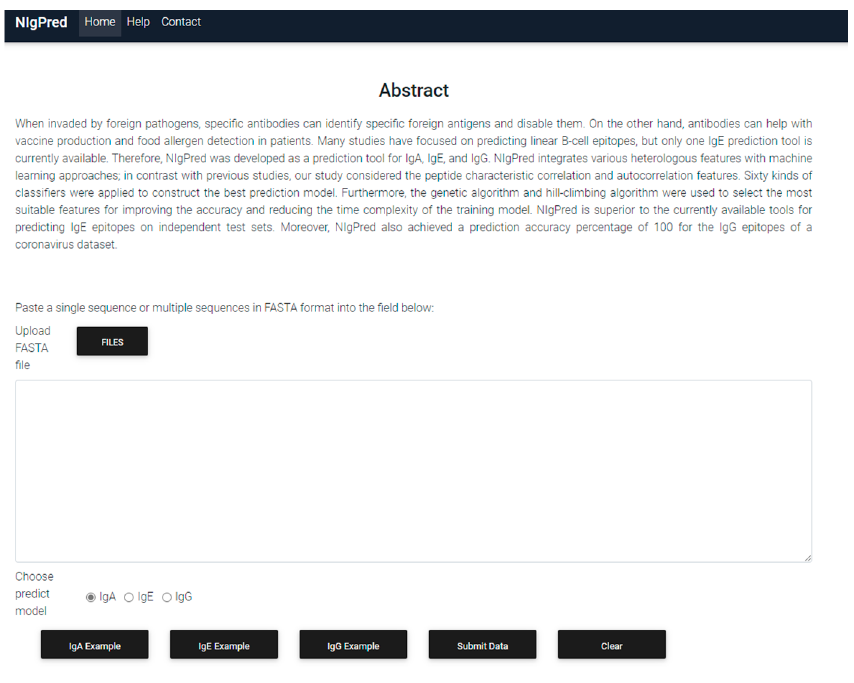
Figure 5. Website of the NIgPred tool.